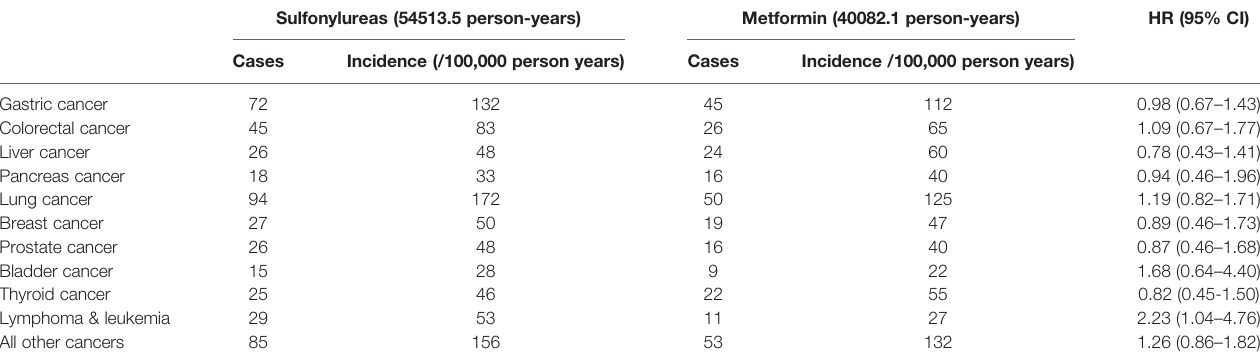
TABLE 4 | Association between the use of sulfonylurea and the risk of site-speci fi c cancer.